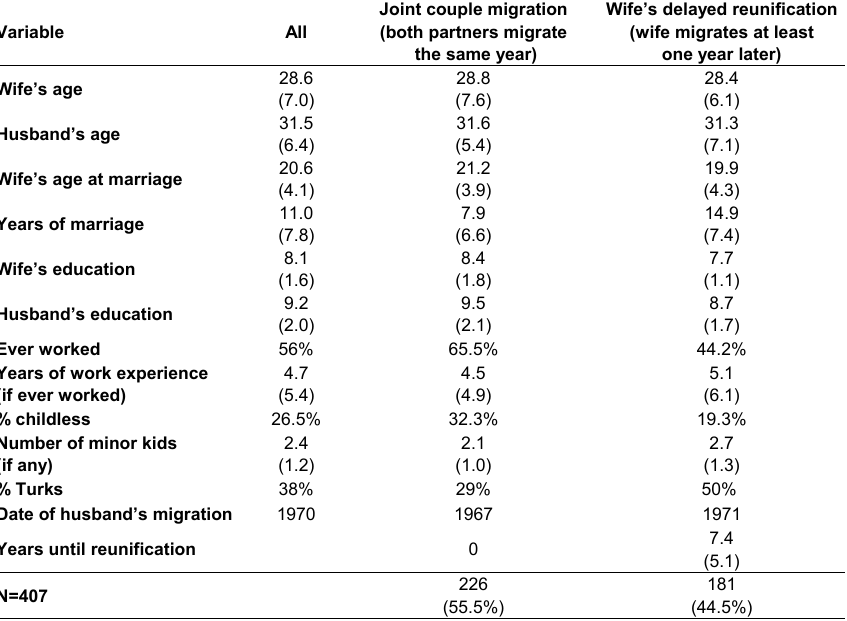
Table 1. Characteristics of reunited wives at the time of their husband’s migration